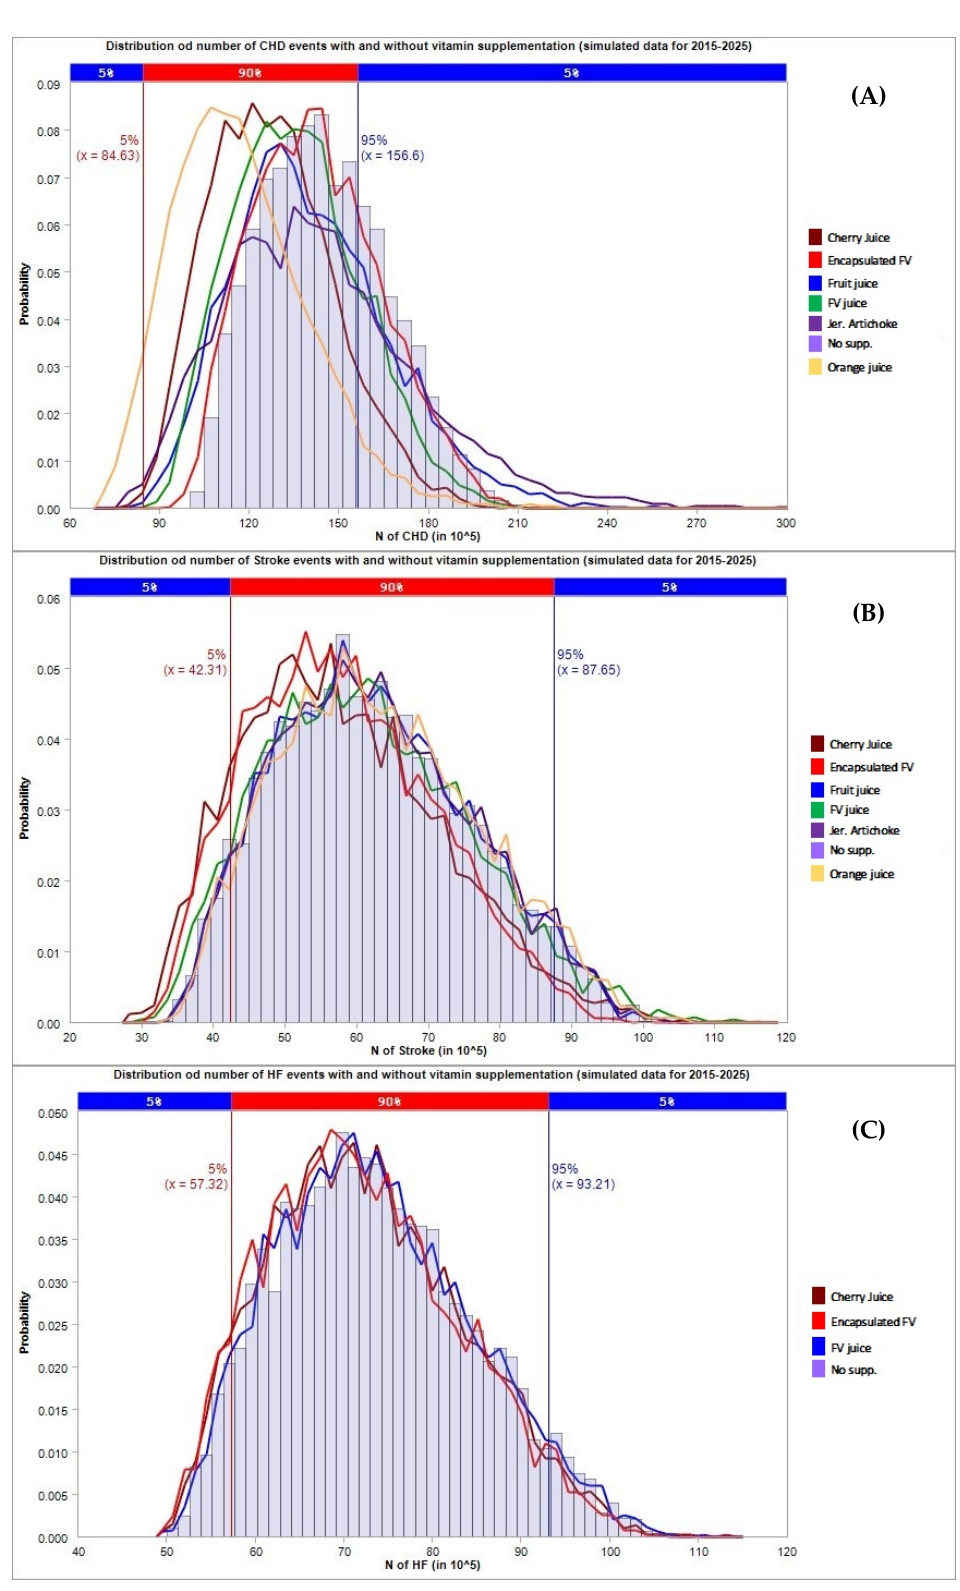
Figure 4. Number of cardiovascular events avoided under different supplementation regimes (estimates for the population with metabolic syndrome). The first chart ( A ) refers to CHD cases, the second chart ( B ) refers to stroke cases, the third chart ( C ) refers to HF cases.